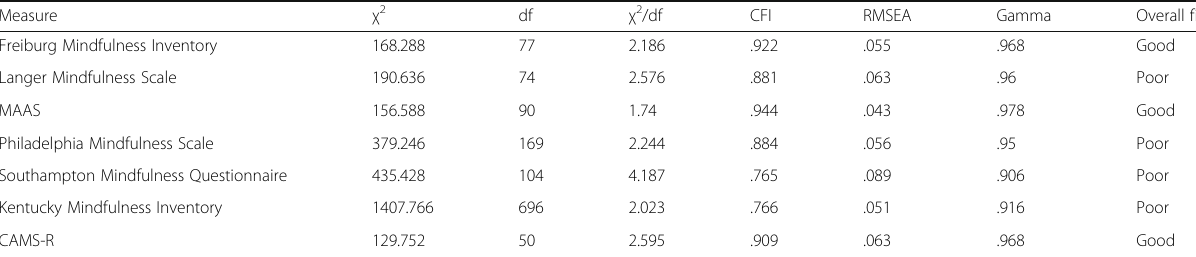
Table 2 CFA fit of the individual mindfulness measures Measure χ 2 df Freiburg Mindfulness Inventory